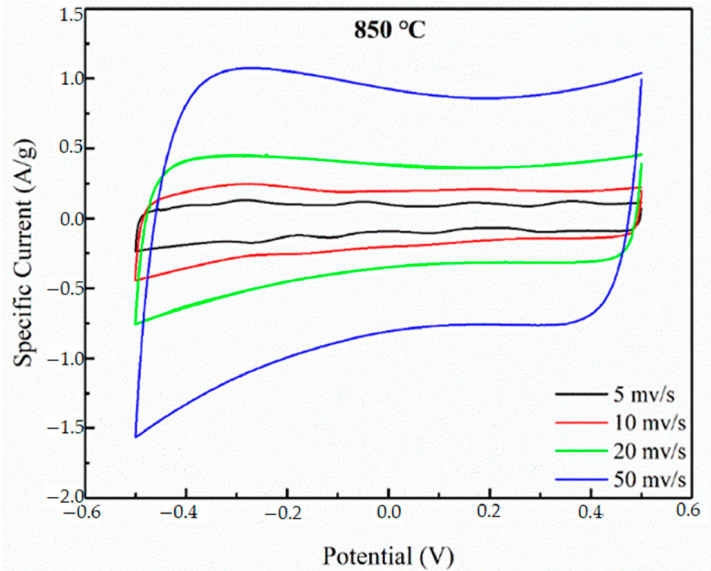
Figure 12. CV curves at 850 at scanning rates of 5 mV/s, 10 mV/s, 20 mV/s, and 50